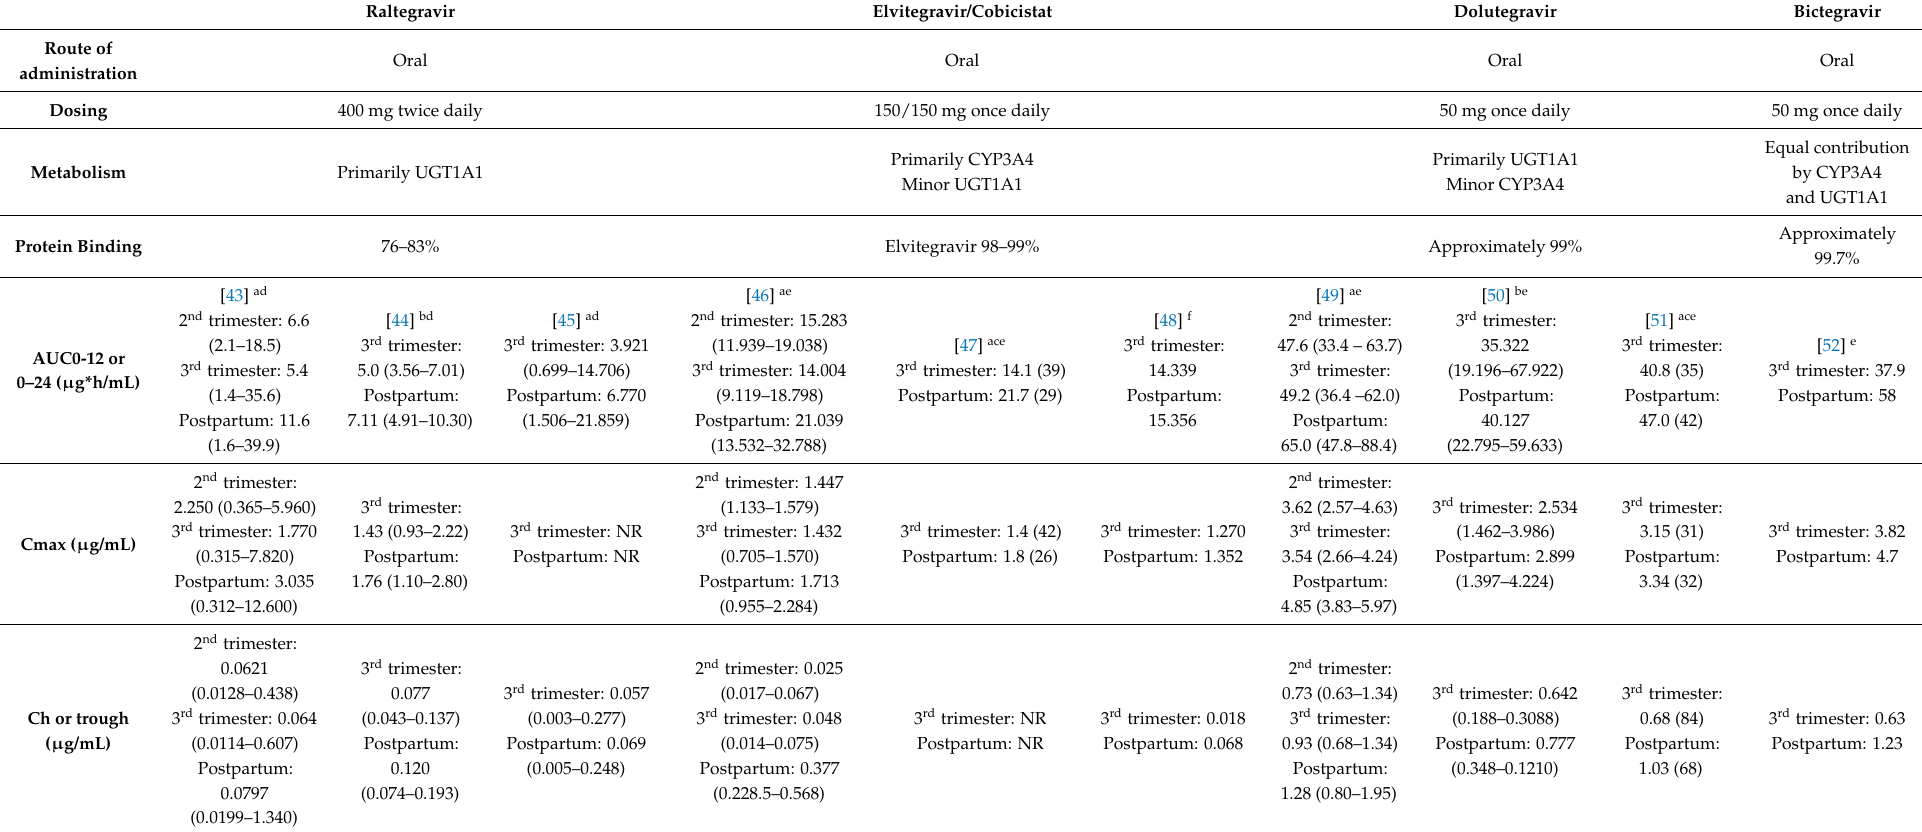
Table 2. Overview of PK of INSTIs during